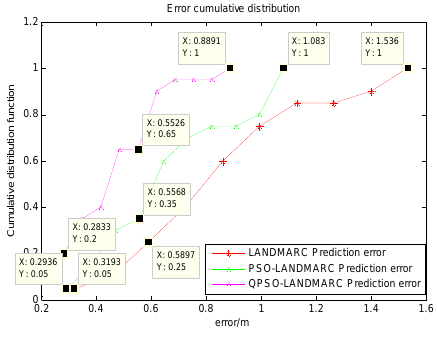
Figure 5. Error cumulative distribution.